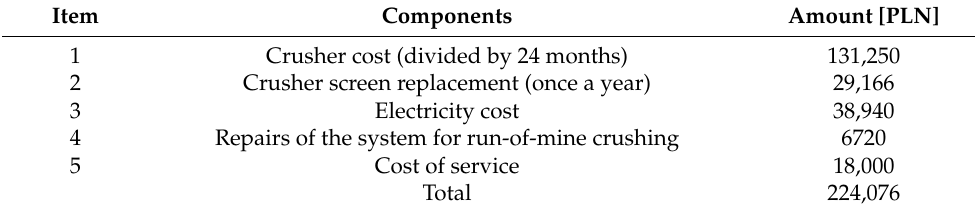
Table 5. Monthly operating costs for the selective crushing system.